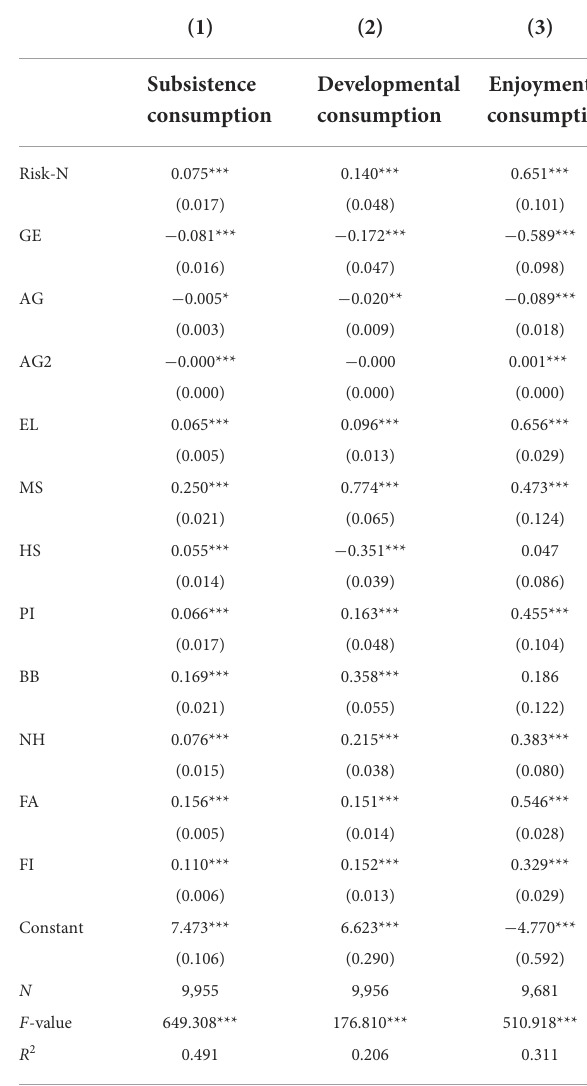
TABLE 5 The impact of risk neutrality on different consumption types of